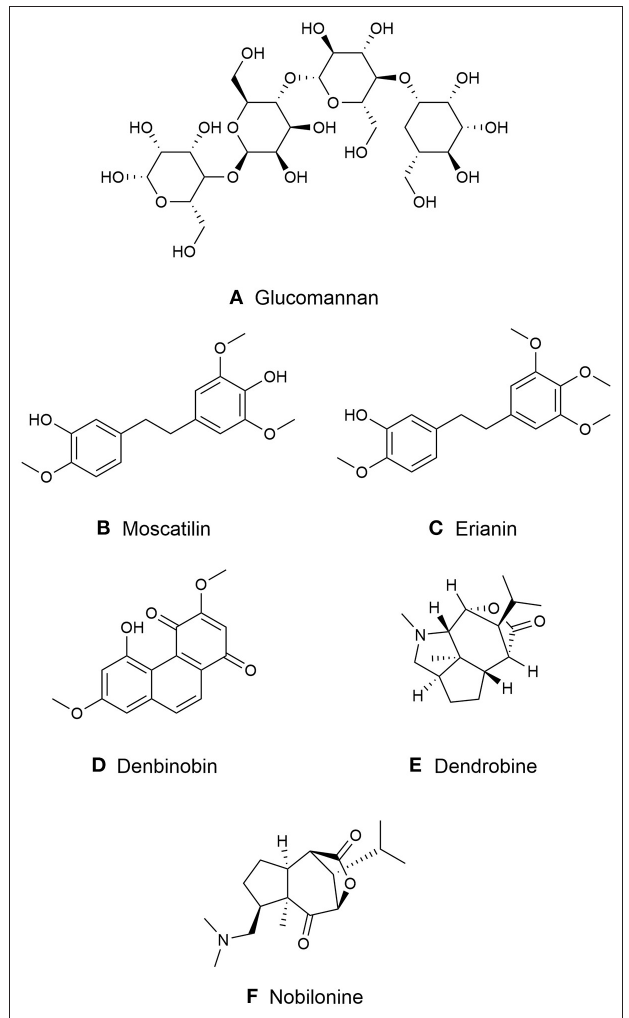
FIGURE 2 | Major chemical compounds in medicinal Dendrobiums . (A) Glucomannan; (B) Moscatilin; (C) Erianin; (D) Dendrobine; (E) Denbinobin; (F)